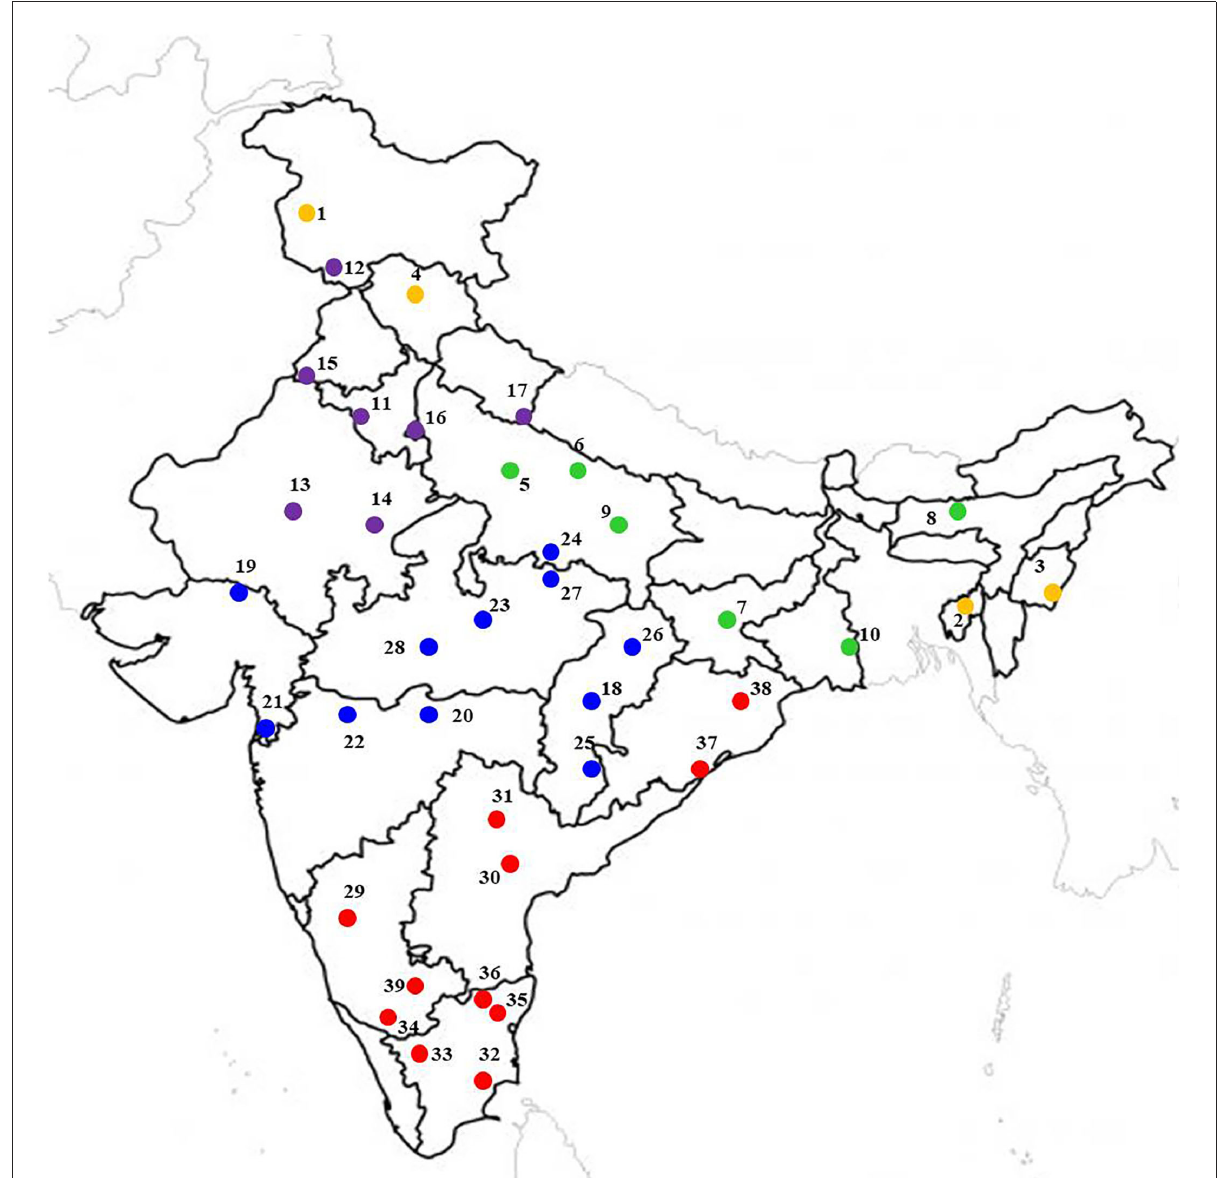
FIGURE1 Multi-location study sites located at major mungbean producing areas in different agroecological zones of India. The yellow, green, violet, blue, and red color location dot represents North Hill Zone (NHZ), North Eastern Plain Zone (NEPZ); North Western Plain Zone (NWPZ); Central Zone (CZ), and South Zone (SZ),